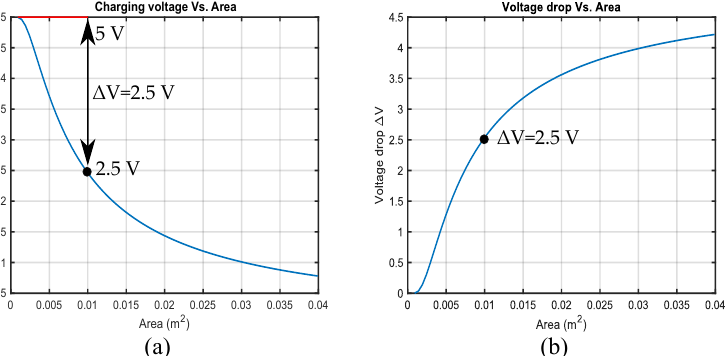
Figure 5. Sensor’s voltage: ( a ) voltage–area relation; ( b ) voltage drop versus increase in contact